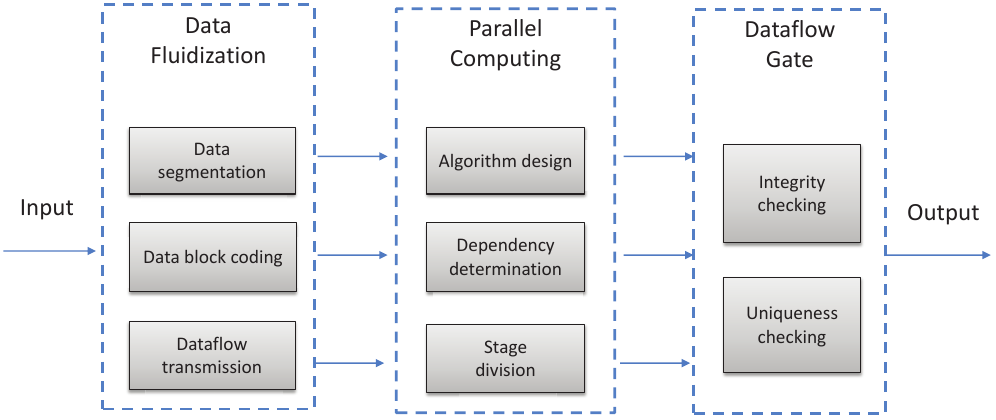
Figure 5. Flow-process diagram of DFS. This pattern contains three parts: data fluidization, parallel computing, and dataflow gate.